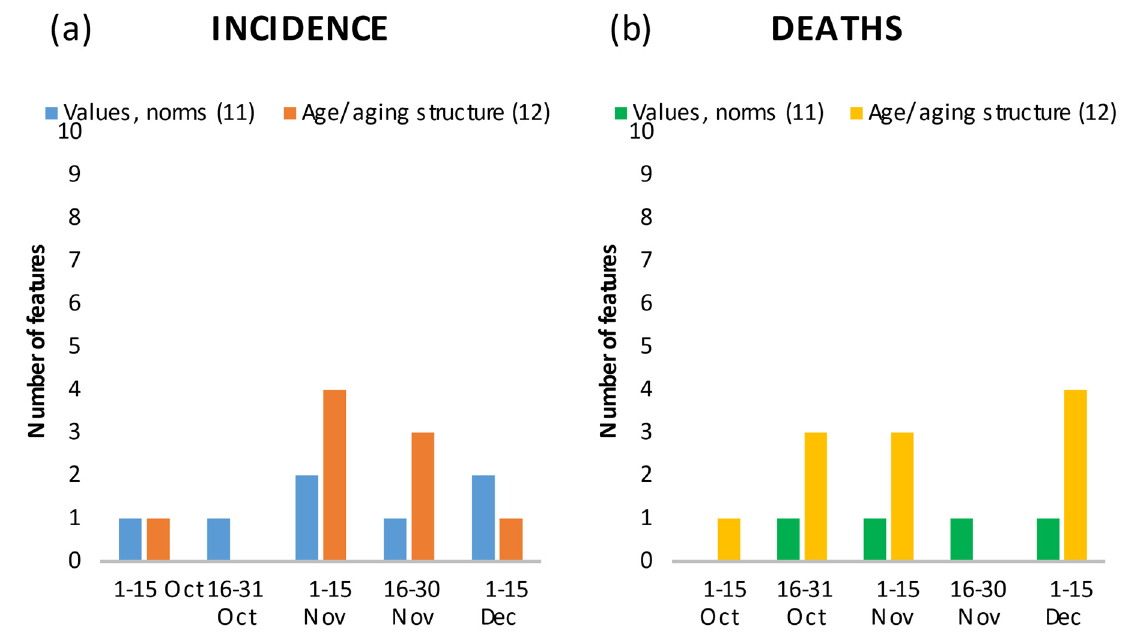
Figure 7. Number of features in the top 20 showing the relationship between values/norms and age/ageing structure, and incidence ( a ) and death rates ( b ) by time period.